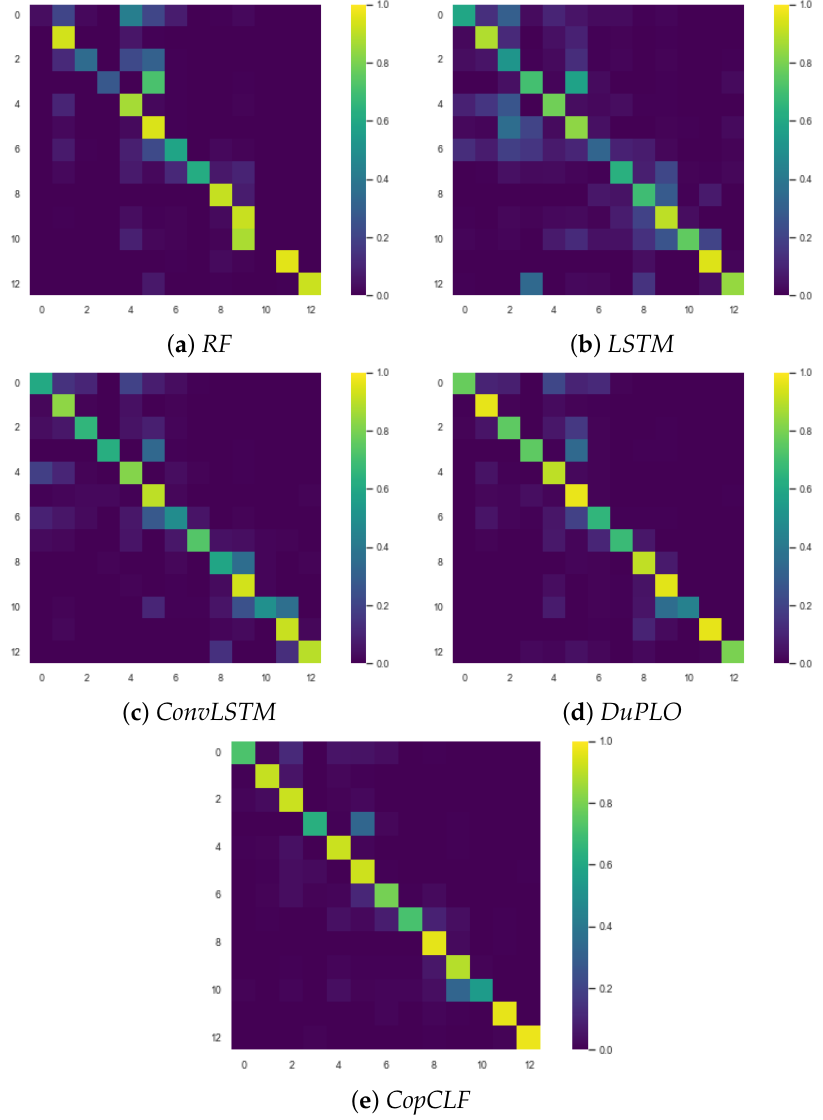
Figure 4. Confusion matrices representing the heatmaps of: ( a ) RF, ( b ) LSTM, ( c ) ConvLSTM, ( d ) DuPLO and ( e ) Cop CLF on the Reunion Island